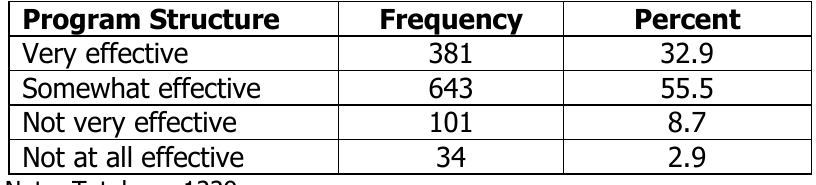
Frequency and percent values for perceptions of effectiveness